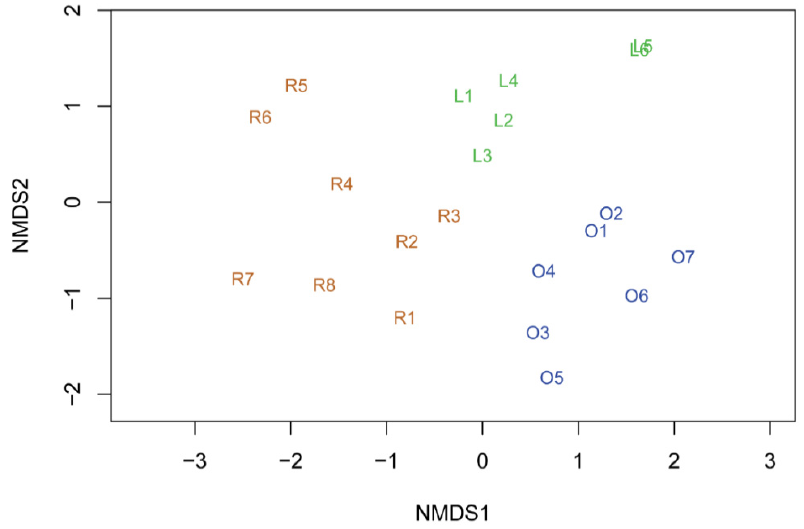
Figure 3. Automated ribosomal intergenic spacer analysis (ARISA) profiles of the microbial communities. ( A ) tuff rock (left side); ( B ) dark fresco (end wall); ( C ) light fresco (right side). The non-metric multi-dimensional scaling (NMDS) plot built on ARISA profiles allowed the identification of three groups (stress = 0.101), roughly corresponding to the three substrata (Figure 4). Samples from the tuff rock substratum are the most heterogeneous, followed by light and dark frescoes, the latter being quite homogeneous.